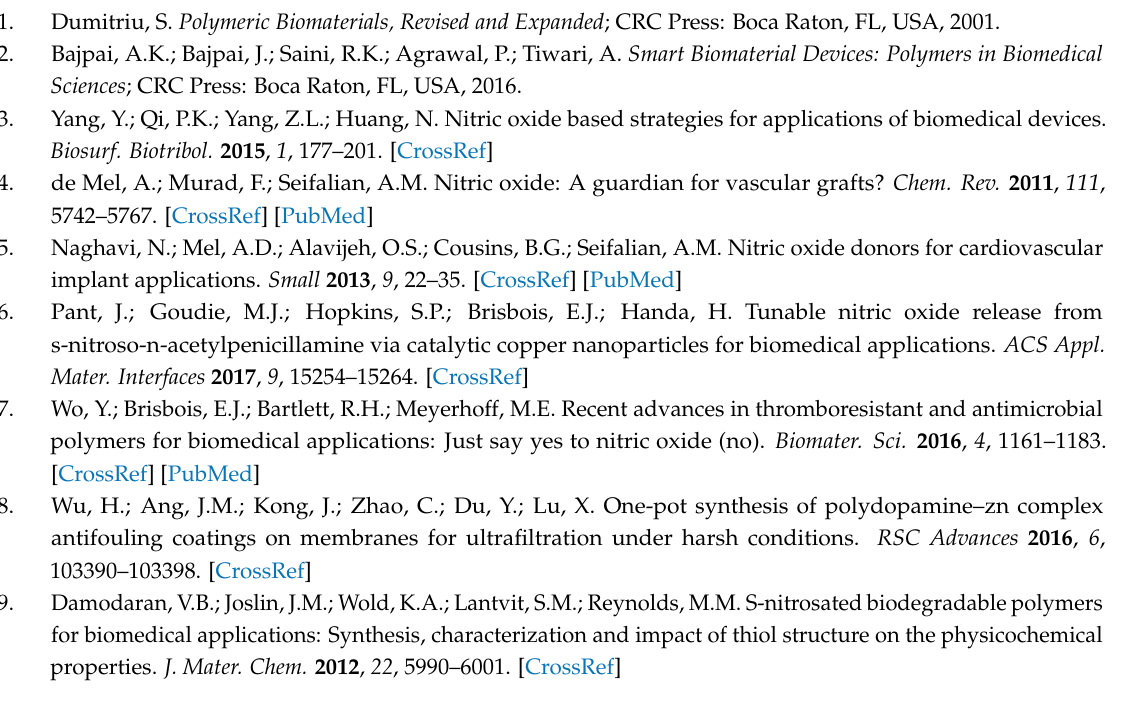
Figure S1: Cu2p 3/2 narrow scan XPS data of four samples, Cu modified PVC and PU with PDA, before and after incubation. Corresponding peaks are assigned following NIST